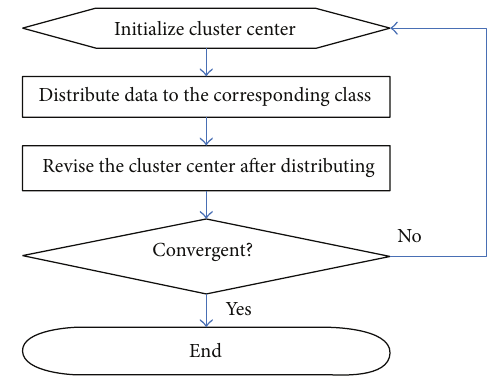
Figure 5: Flow chart of 𝐾 -means